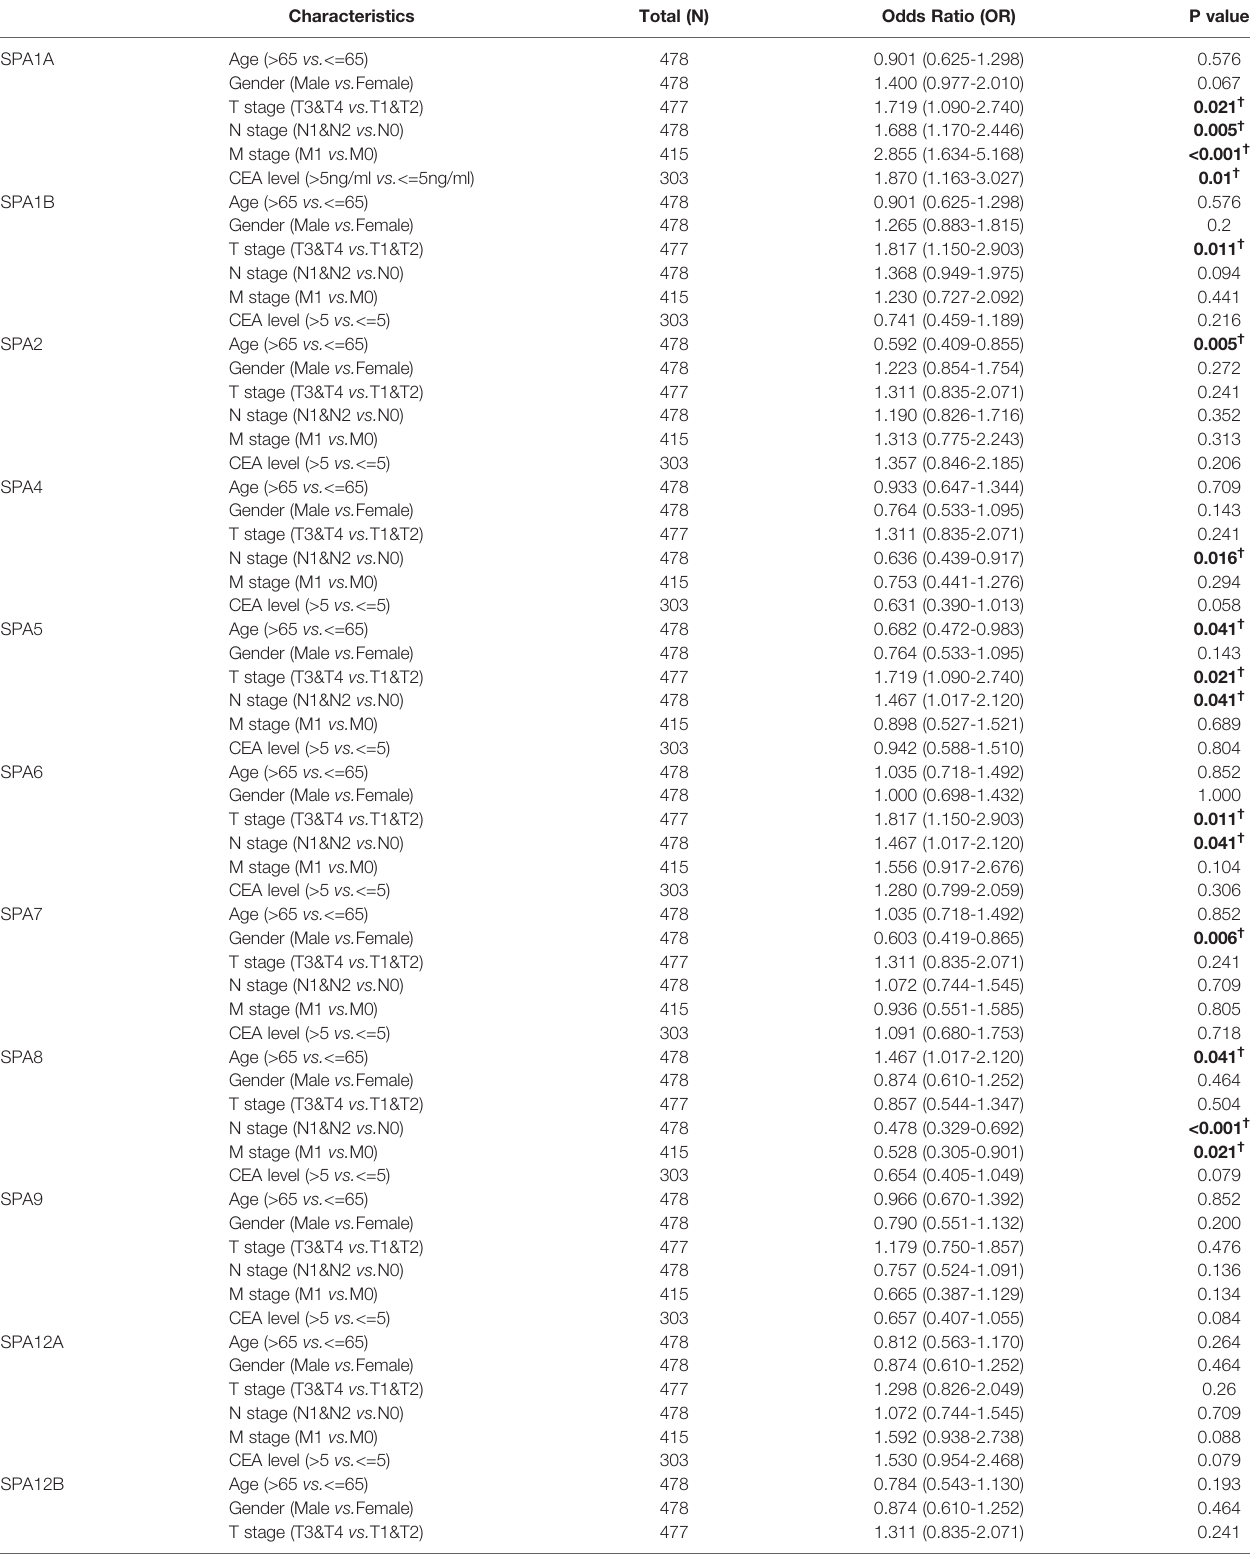
TABLE 1 | Correlation of HSPA family expression with clinical pathological characteristics in colon cancer analyzed by Logistic